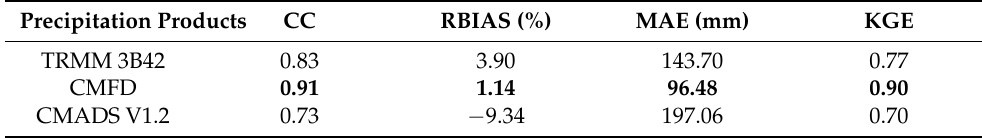
Table 5. Values of statistical indicators at the yearly